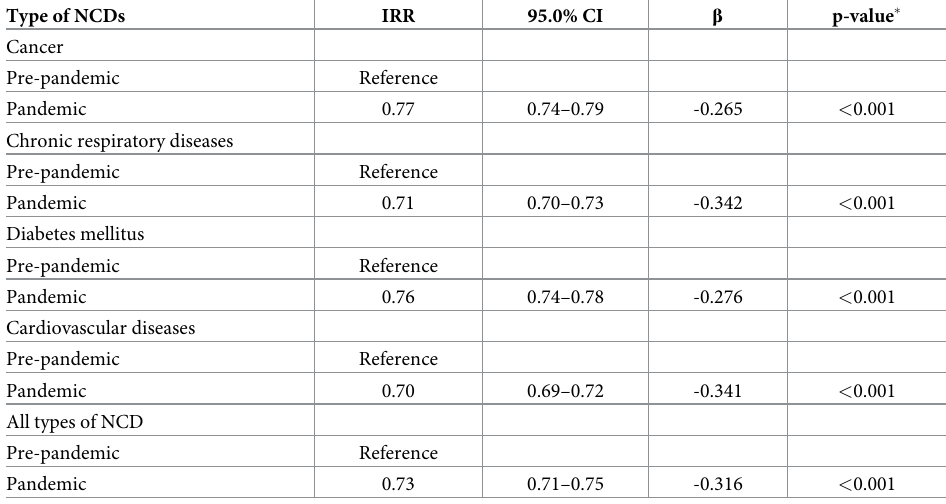
Table 5. Poisson multiple regression models of the impact of the coronavirus disease pandemic on hospital admissions for chronic non-communicable diseases (NCDs) in Brazil according to the type of